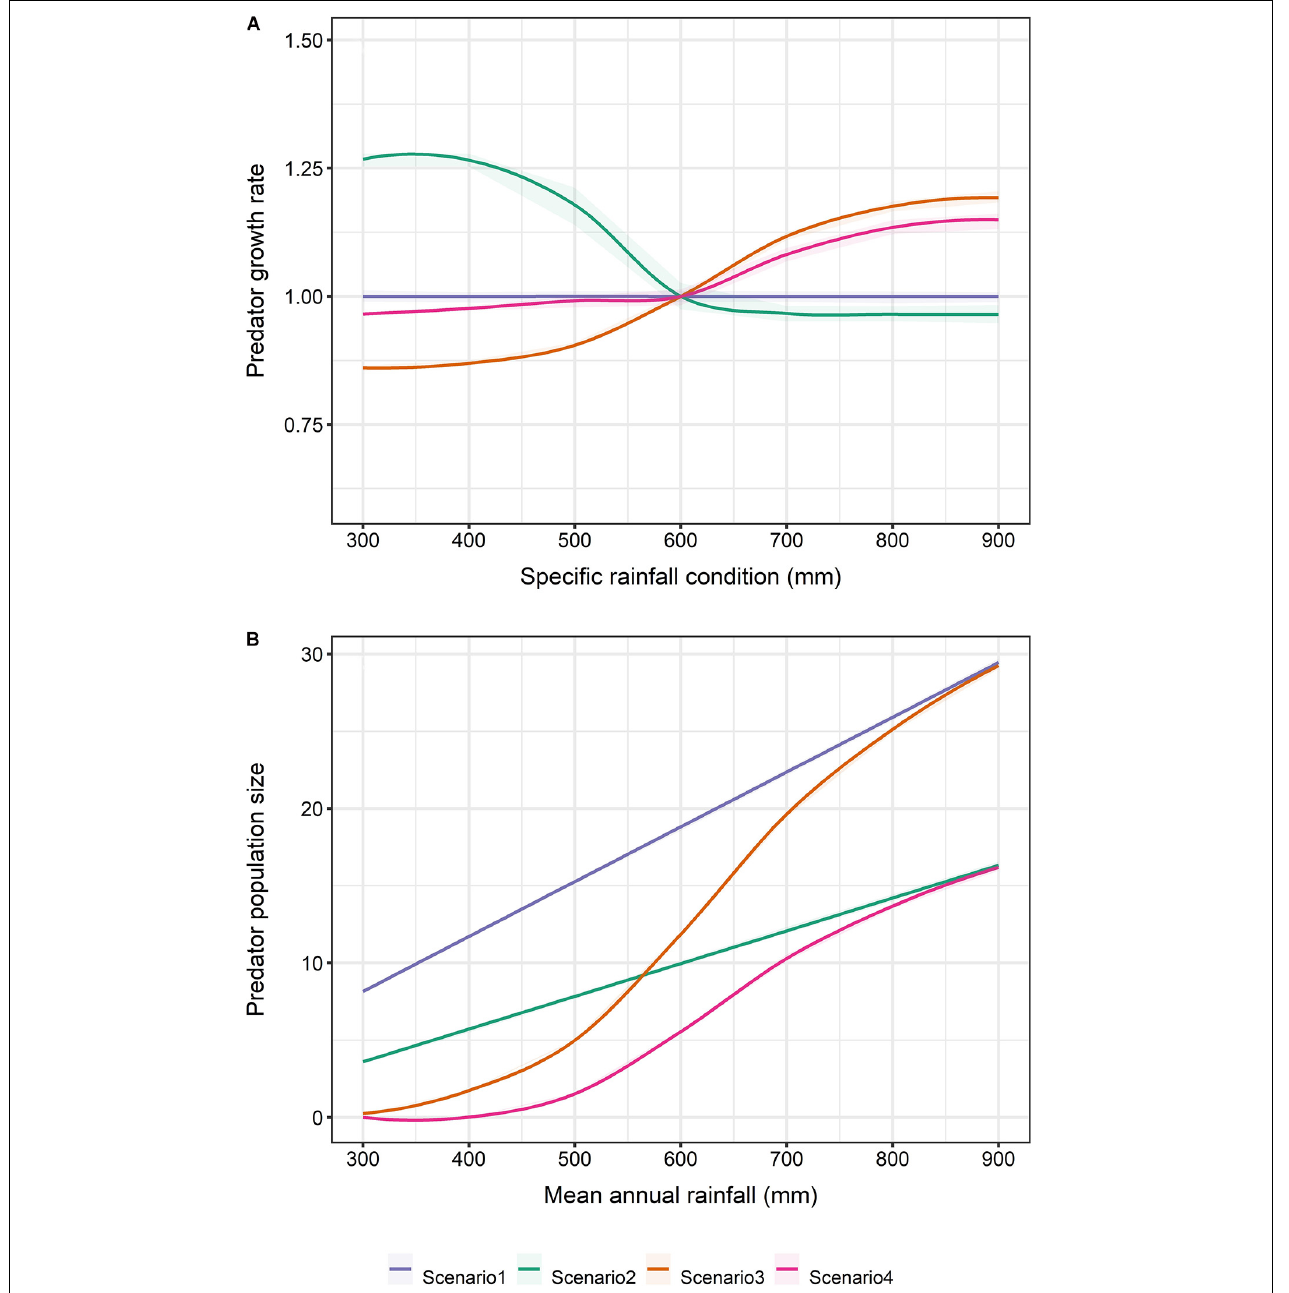
FIGURE 4 | (A) Immediate response of predator populations to a specific rainfall condition. Relationship between the growth rate of predator populations and a specific annual rainfall in a system characterised by a long-term mean annual rainfall of 600 mm. (B) Long-term response of predator populations to changes in mean annual rainfall. Relationship between the size of predator populations and long-term mean annual rainfall. While in scenario 1, prey vulnerability to predators did not vary with climatic conditions, in scenarios 2–4, climatic conditions affected prey vulnerability through, respectively, changes in prey body condition, in habitat characteristics or both. Light-coloured envelops include minimum and maximum values of predator growth rates (A) or mean predator population sizes (B) .